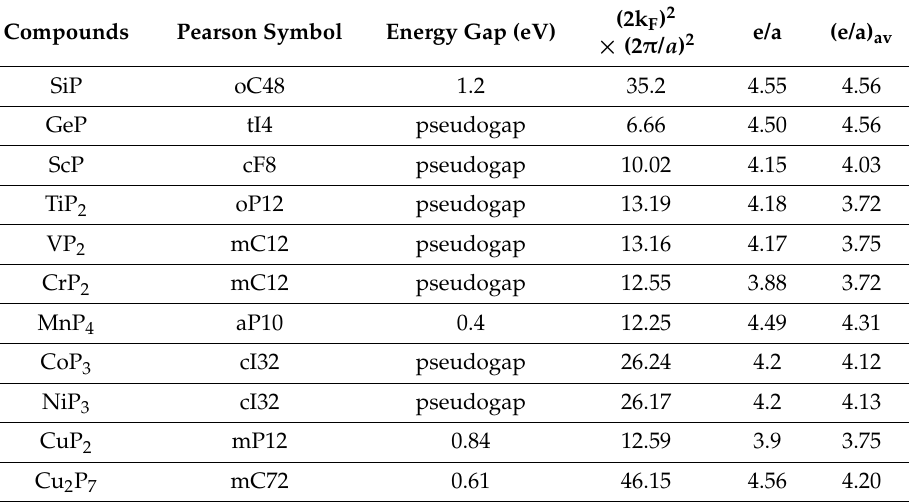
Table 10. P-TM compounds with e/a = 4.0 ± 0.5.